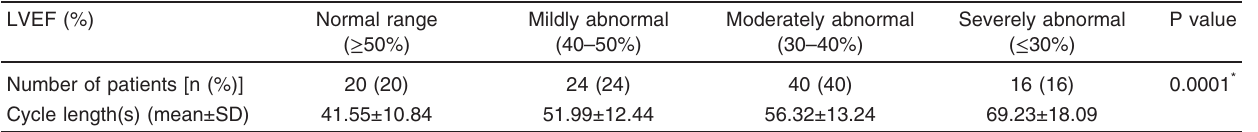
Table 5 Variation in cycle length in Cheyne – Stokes breathing with different severities of heart failure LVEF (%) Normal range ( ≥